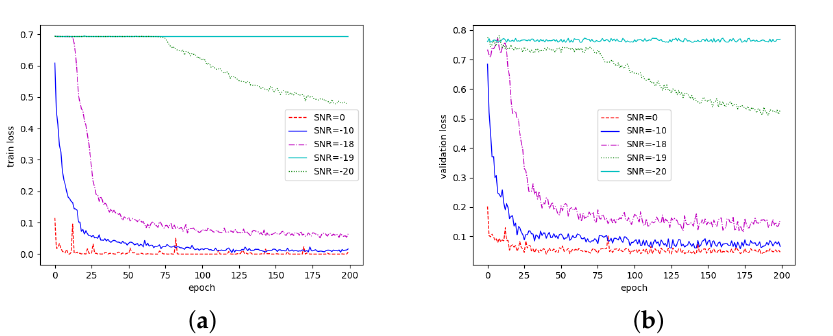
Figure 7. Change of loss value under different SNRs. ( a ) Training loss; ( b ) validation